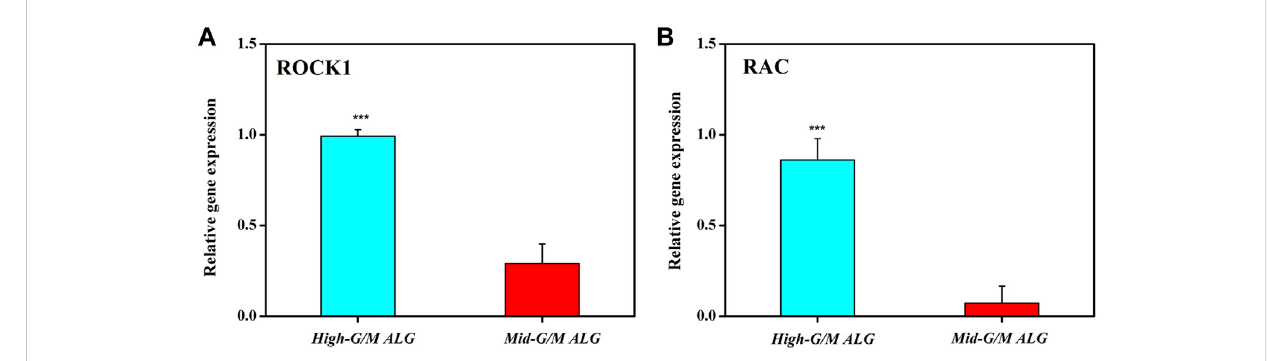
FIGURE 9 Effects oftheG/MratiosofALG/COLhydrogels on (A) ROCK1and (B) RACmRNA expression inchondrocytes, asquanti fi edusingthe2 − ΔΔ Ct method at 14 days. Dates are represented as the mean ± SD (n = 3). (*** p < 0.001 indicates a signi fi cant difference between the